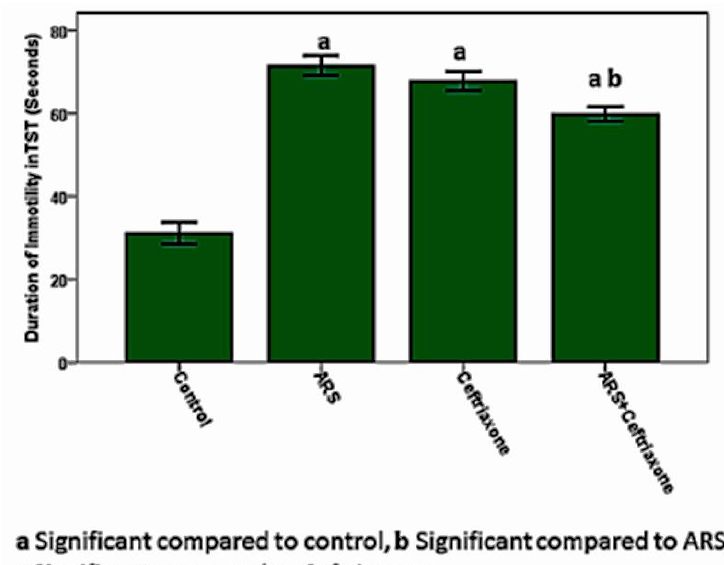
Figure 3. Duration of immobility in the tail suspension test.